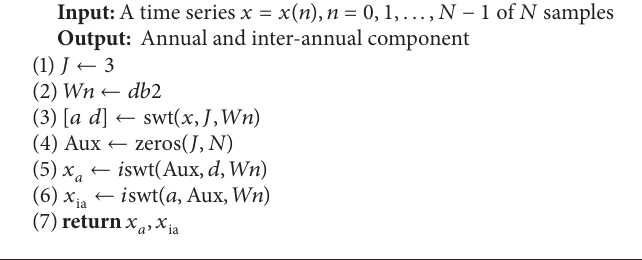
Algorithm 1: Component